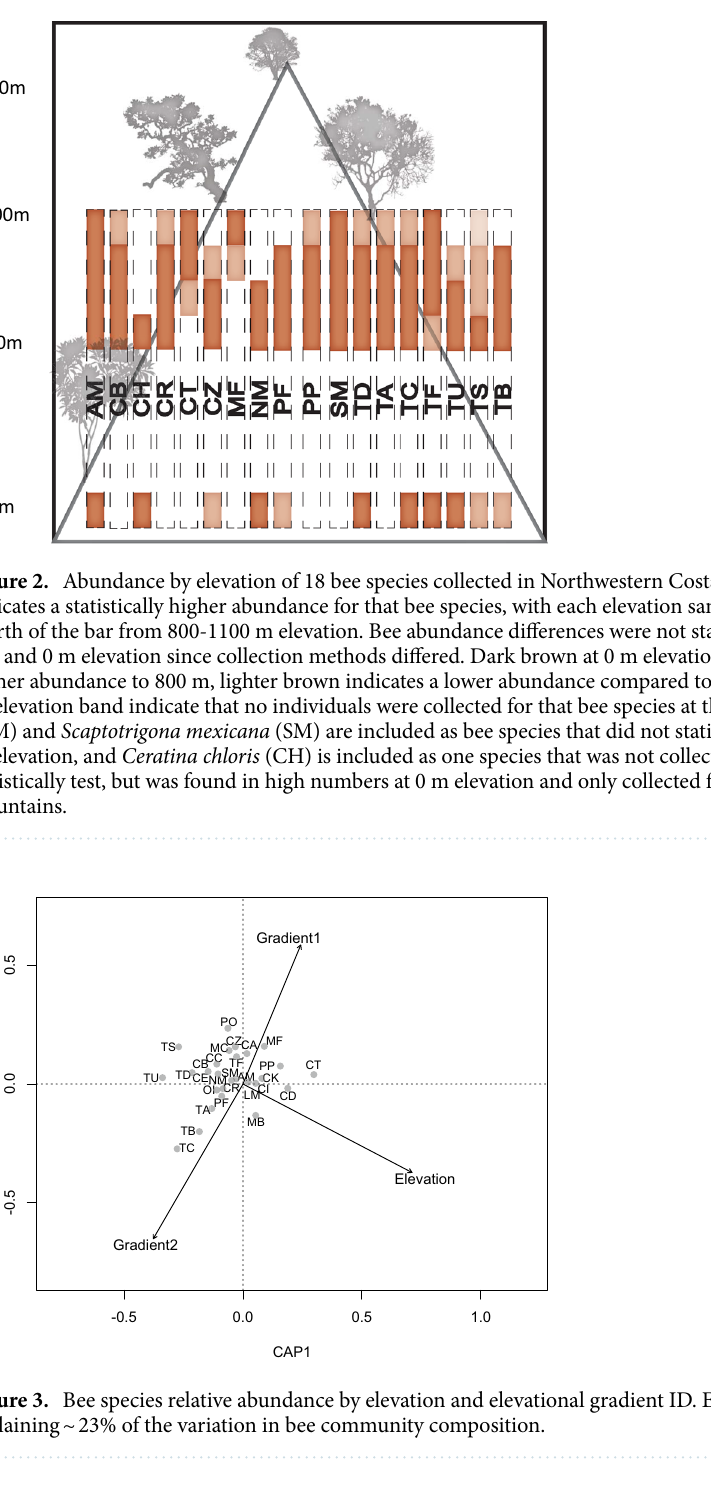
appear to approach an asymptote (Supplementary Fig. S8). The bee community visiting avocado was more spe- cies rich than squash (Supplementary Fig. S9), and hosted a distinct assemblage of bee species, sharing only 4 of 26 species collected (Fig. 4; Supplementary Table S6). For avocado, the lower elevations 700, 800, and 900 m elevation shared more similar communities, while bee communities of 1000 and 1100 m elevation were simi- lar. For squash, the bee community at 1000 m elevation was more distinct from the other elevations (Fig. 4). Crop species explained 57% of the variation in bee community composition ( F pseudo1,6 = 12.75, p = 0.001) while elevation explained 17% of the variation in bee community composition ( F pseudo1,6 = 3.93, p = 0.029; Supplemen- tary Fig. S10). Threshold species identified as species with abundances that decreased with increasing elevation included Trigona corvina and Tetragonisca angustula and species that increased in abundance with increasing